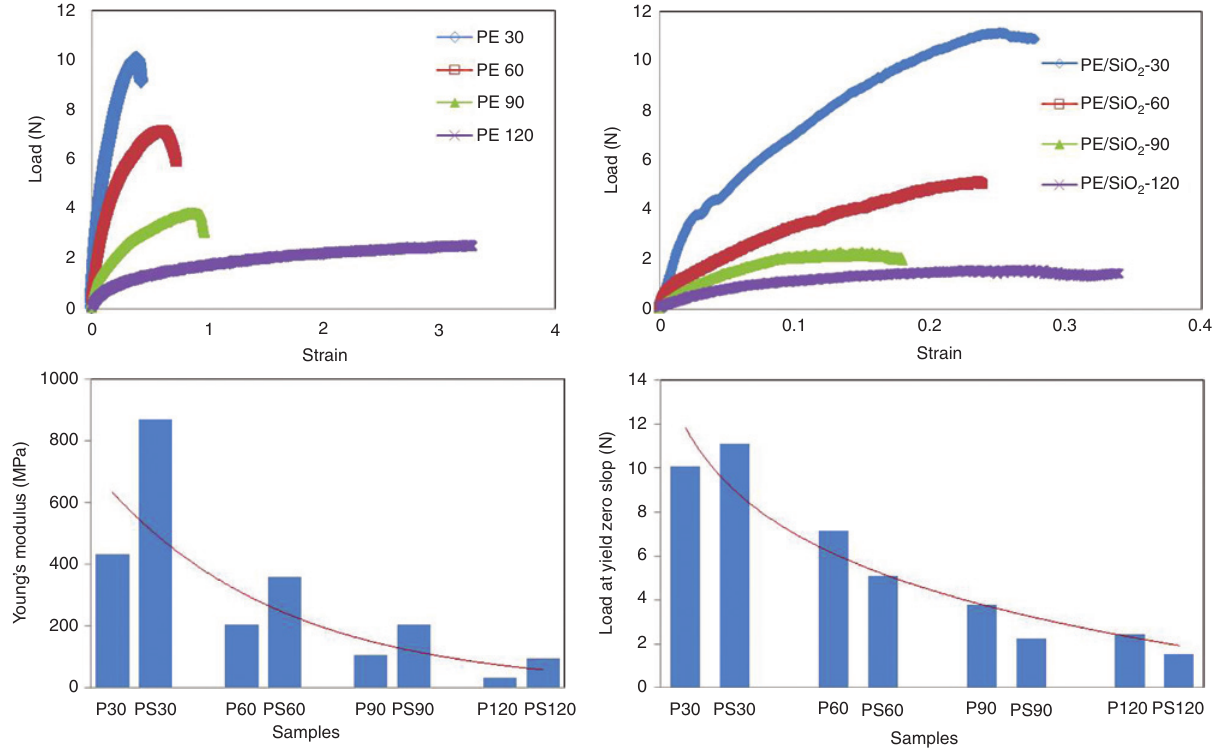
Figure 7: Thermotensile of membrane composites by Instron under 30 ° C, 60 ° C, 90 ° C, and 120 °